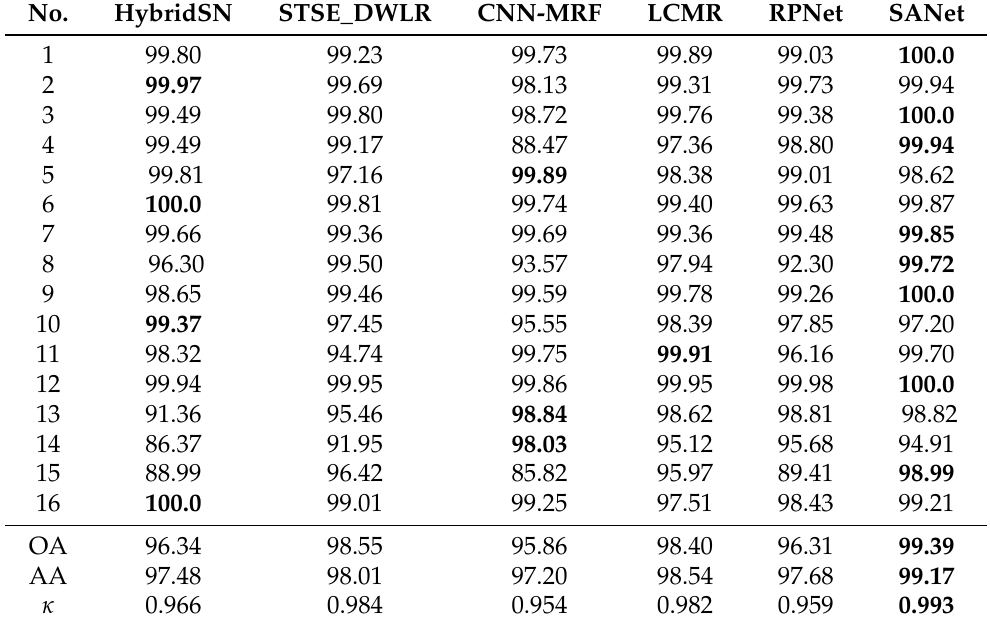
Table 4. Classification accuracies of HybridSN, STSE_DWLR, CNN-MRF, LCMR, RPNet, and SANet on the Salinas data set. The best results are highlighted in bold font.